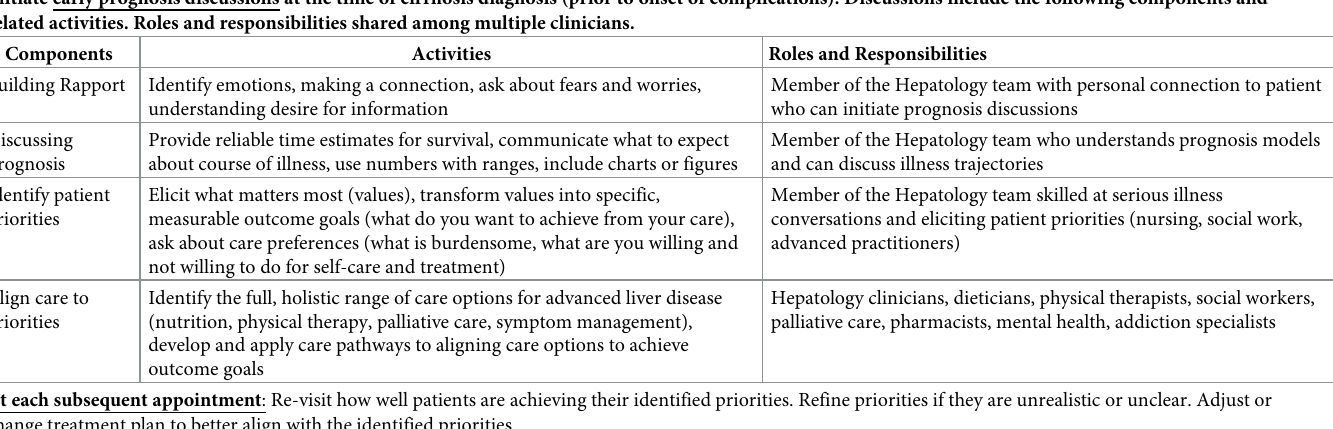
Table 2. Prognosis discussions for an integrated approach to advanced liver disease care. Initiate early prognosis discussions at the time of cirrhosis diagnosis (prior to onset of complications). Discussions include the following components and related activities. Roles and responsibilities shared among multiple clinicians.